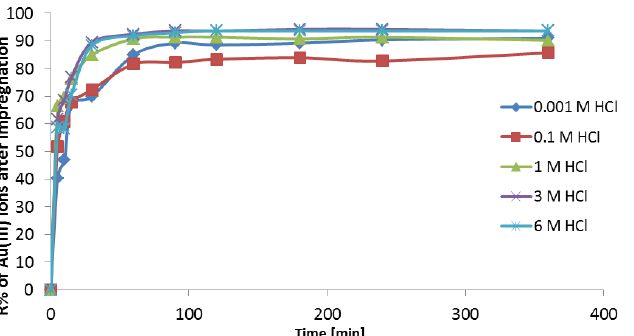
Figure 6. Influence of hydrochloric acid concentration and phase contact time on the removal of Au(III) ions (100 µ g · cm − 3 ) from the aqueous solution using Purolite MN 202 impregnated with Cyanex 272.